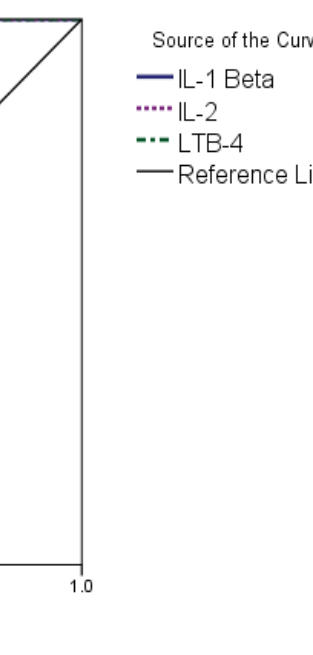
Figure 1. Parameters of the high-value predictors of mortality.